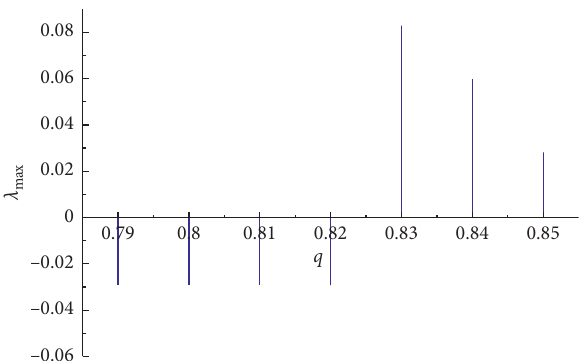
Figure 2: The largest Lyapunov exponent with the variation of derivation order q